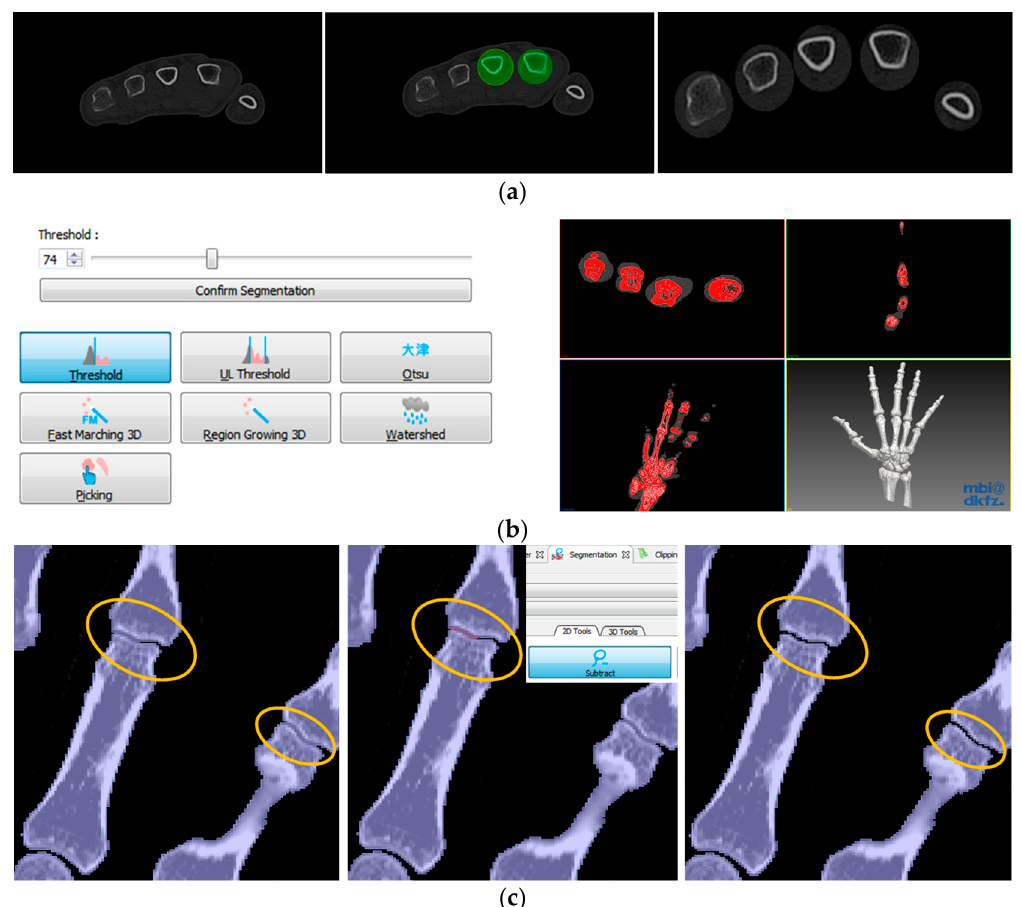
Figure 3. Reconstruction of 3D hand skeleton from a computed tomography (CT) scan: ( a ) Masking the hand bones to remove the hand skin, left: original CT scan in an axial view, middle: masking the bones using a scalable sphere, right: masked CT scan; ( b ) Segmentation of the hand skeleton from the masked CT scan using a threshold-based segmentation method in the Medical Imaging Interaction Toolkit (MITK); ( c ) Separation of the connected hand bones using a subtraction function in the Medical Imaging Interaction Toolkit (MITK), left: connected hand bones, middle: separation of the hand bones connected, and right: separated hand bones.